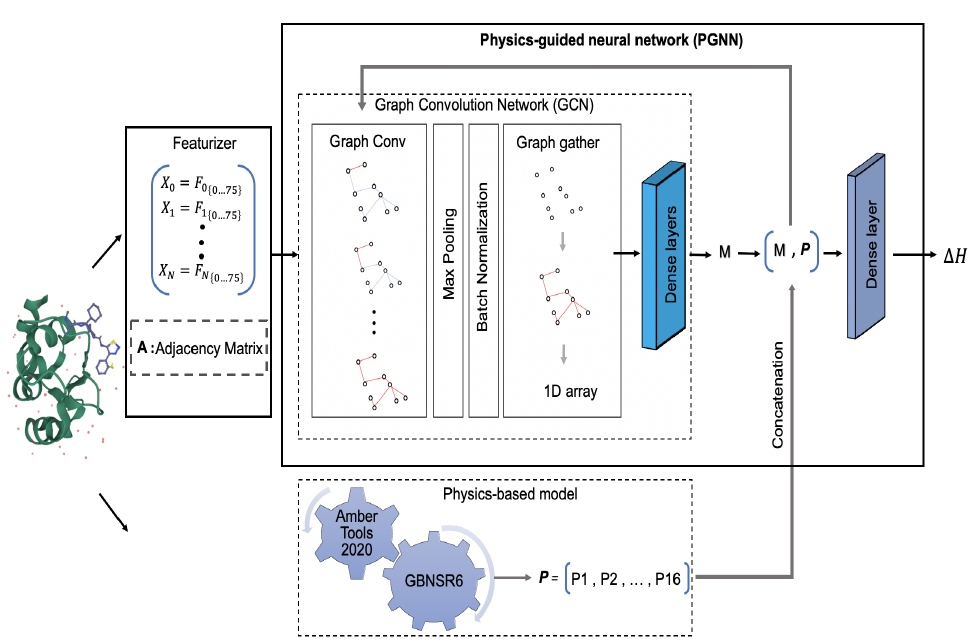
Figure 1. Workflow of the proposed PGNN model. The sample input structure, the complex of the BIR domain of MLIAP and GDC0152, is selected from the PDBbind refined set [58]. After featurization, the structure-based features along with the adjacency matrix A enter the network. The results of the first network iteration are the model variable M . The output of the physics-based model is vector P , which is concatenated with M . The resulting vector goes through several iterations before entering the final dense